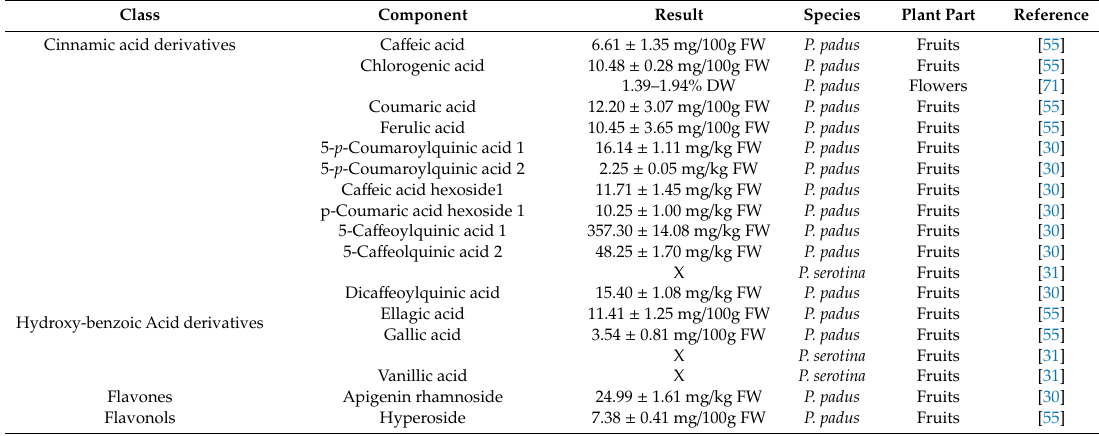
Table 5. Polyphenolic compounds in wild cherries ( P. padus and P. serotina